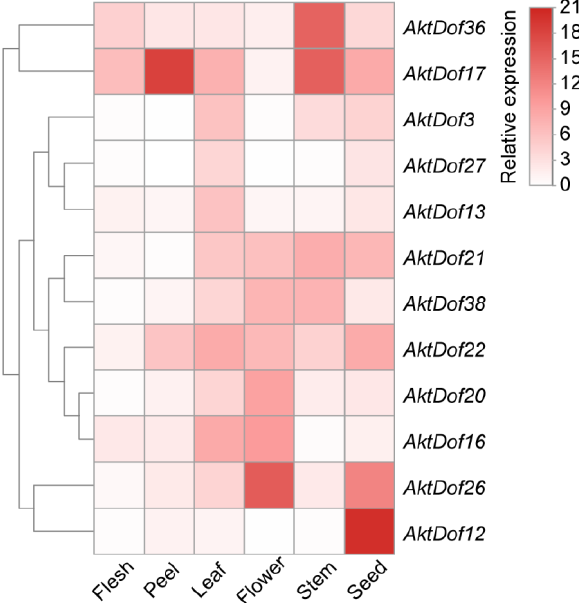
Figure 4. Expression profiles of 12 AktDofs in different tissues. The variation in the degree of white to red indicates the intensity of the expression level. The calculation of the relative expression level was based on that of the GAPDH gene as the internal reference, and the expression level of the gene was calculated by the 2 −ΔΔCt method.